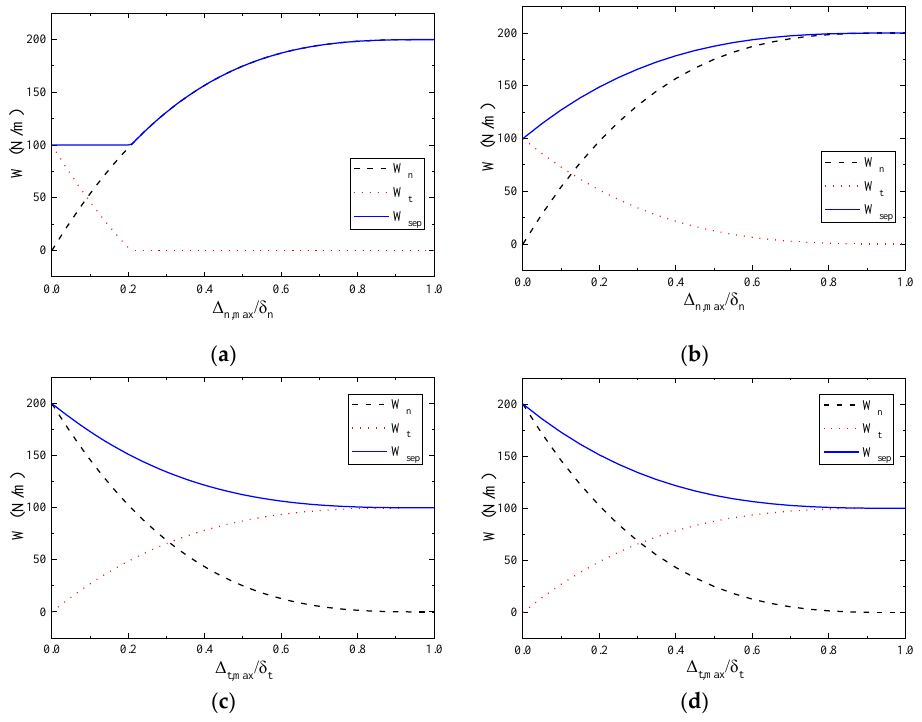
Figure 9. Variation of the work-of-separation for the case of 𝜙 𝑛 > 𝜙 𝑡 ( 𝜙 𝑛 = 200 N/m and 𝜙 𝑡 = 100 N/m ): non-proportional Path 1 ( a , b ); or non-proportional Path 2 ( c , d ). PPR model ( a , c ); SPPR model ( b , d ).